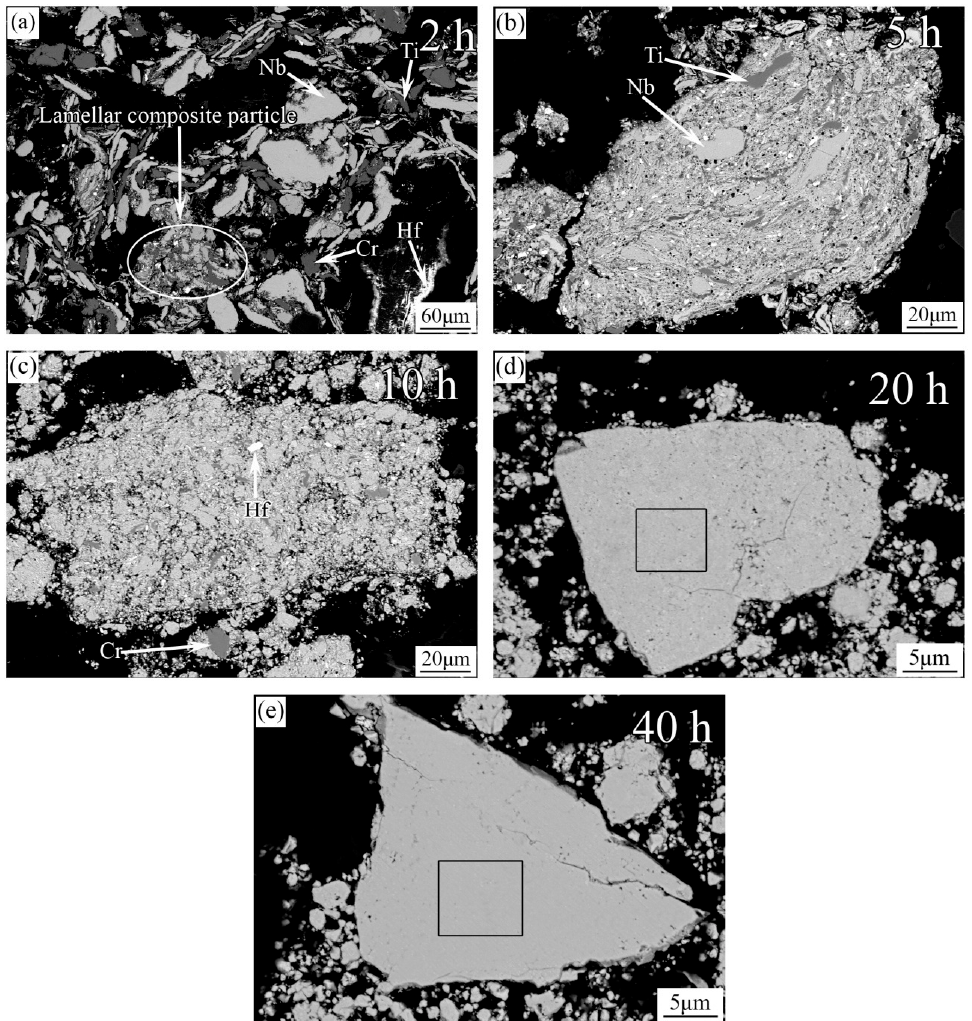
Figure 2. Cross-sectional BSE images of the powders after ball milling for different times at 500 rpm: